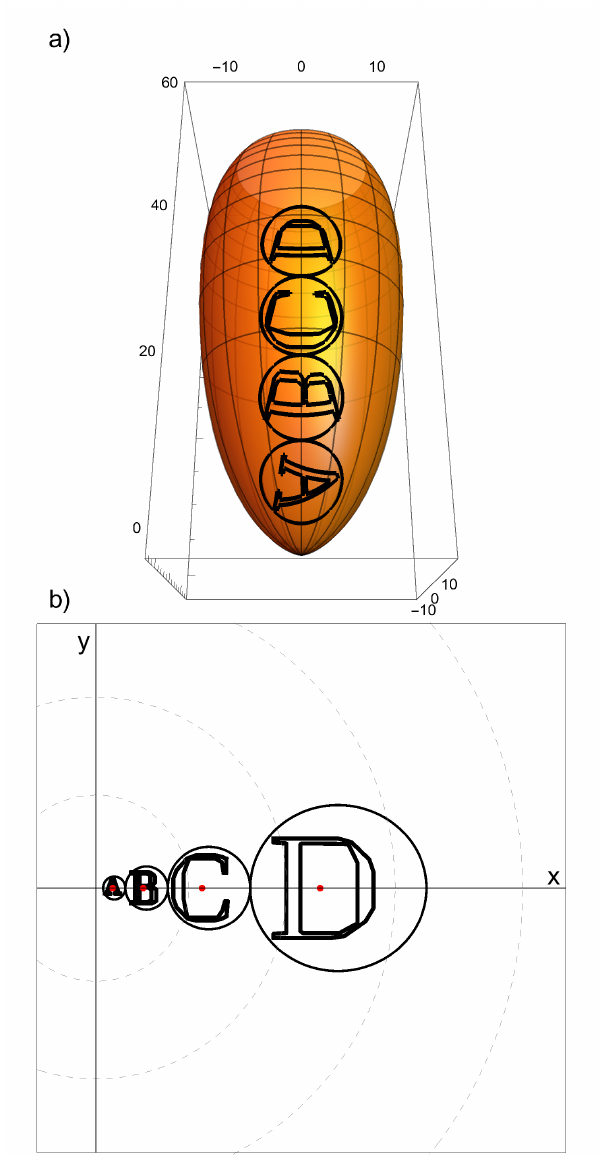
Figure 8. ( a ) geodesic circles of radius 5 tangent to each other and centered along the φ = 0 meridian on V 1; ( b ) stereographic projections of the V 1 four circles to the E 2 plane. Scripts of the first four letters of the alphabet are inscribed inside the circle images on E 2 . Their inverse diffeomorphic images are mapped back to the V 1 surface to illustrate surface magnification and orientability. A = 525.6 and B =